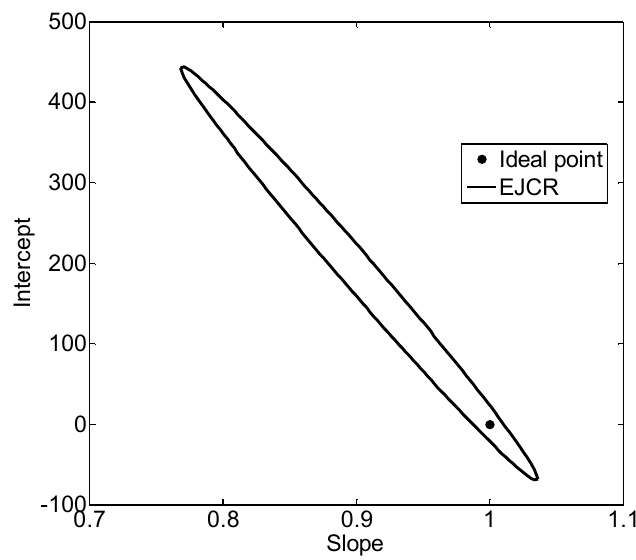
Figure 3. Elliptical joint confidence regions (EJCR) for predicted acid ascorbic content in acerola samples. Validation of the optimized multivariate calibration model for ascorbic acid determination was confirmed by the FOM, presented in Table 4. A reasonably low signal-to-noise ratio of 4.83 indicated that no straight relationship between the reference method and the fitted model was